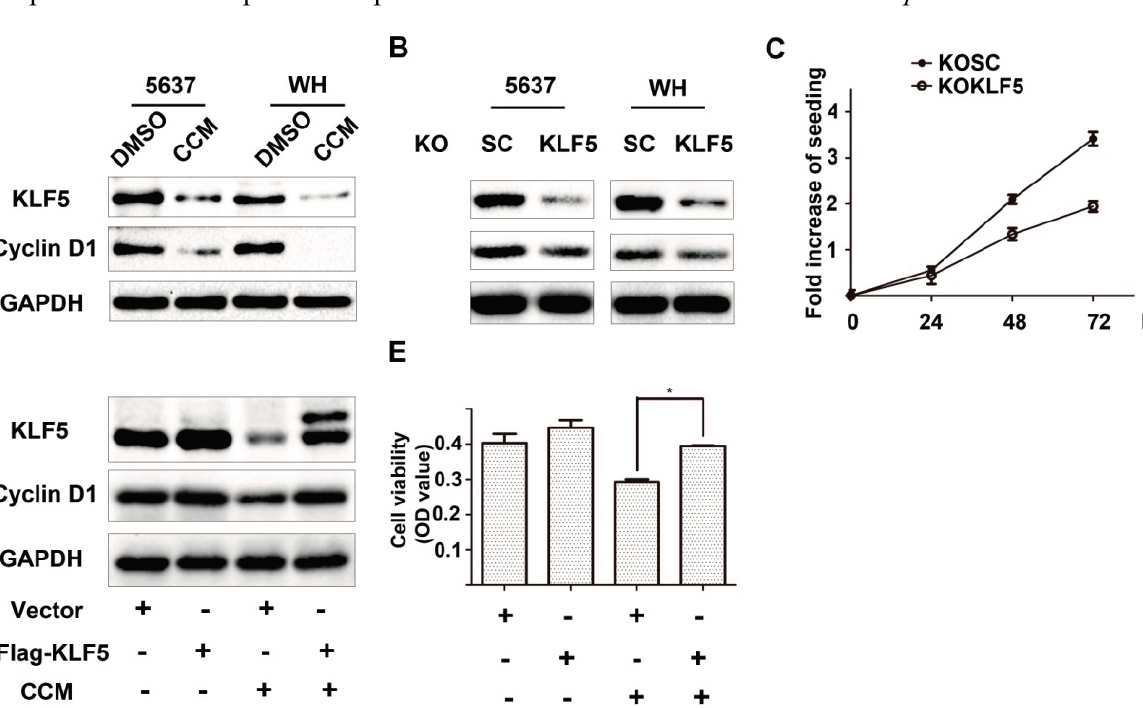
Figure 3. KLF5 mediated the anti-proliferative effect of curcumin. ( A , B ) KLF5 and cyclin D1 expression in curcumin-treated 5637 and WH cells ( A ) and in lentivirus-shKLF5-infected stable cells ( B ), as detected by western blot analysis; ( C ) The growth rates of 5637 KOSC and KOKLF5 cells were determined by the MTT assay; ( D ) Flag-KLF5 or vector-transfected 5637 cells were treated with 15 μ M curcumin for 24 h. Then, cell lysates were harvested, and the KLF5 and cyclin D1 levels were analyzed by the western blot assay; and ( E ) The cell viability of different groups in ( D ) was determined by the MTT assay. The results represent three independent experiments. The values are the mean ± SD. * p <